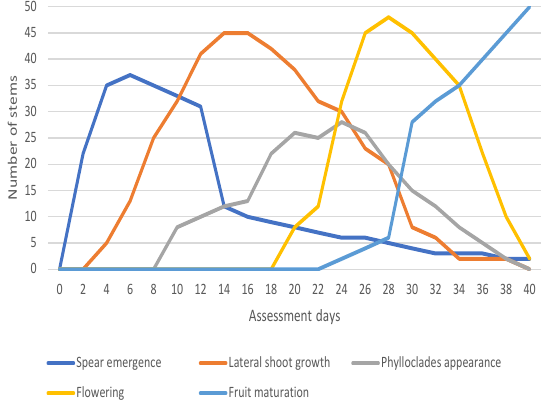
Figure 2. Asparagus growth stages during the first growing season in the Chavimochic Irrigation Project.